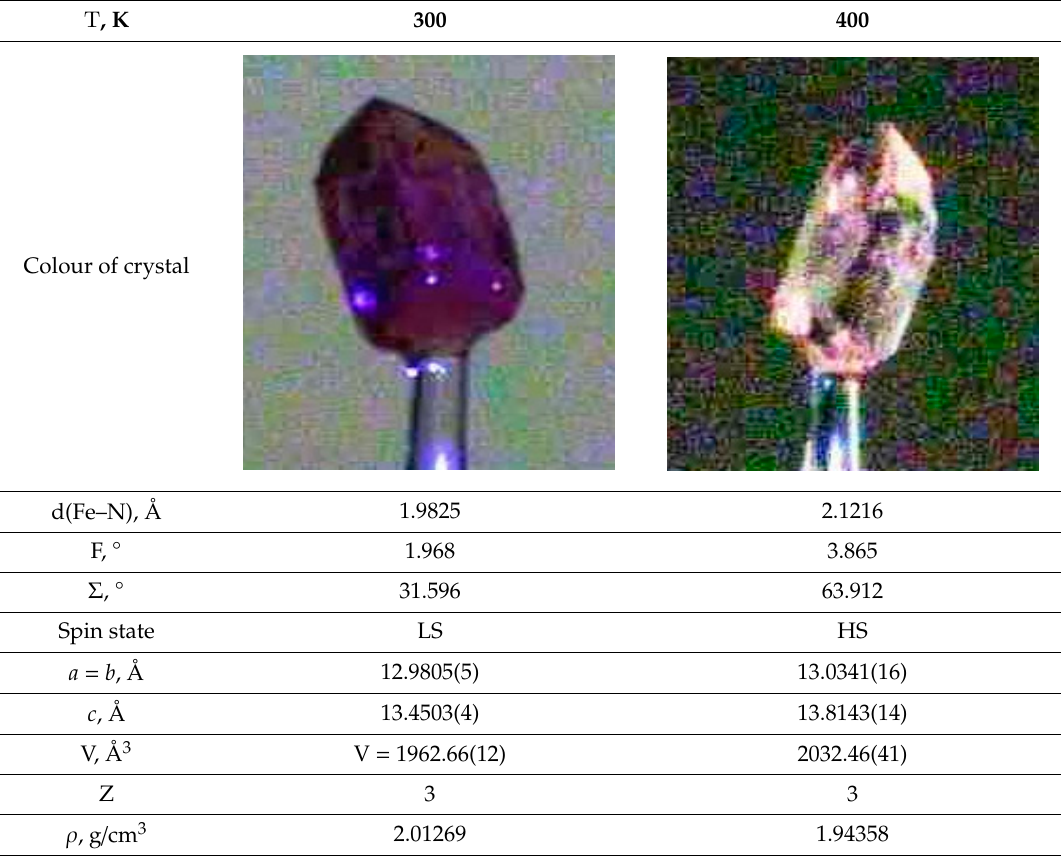
Colour of crystal Colour of crystal